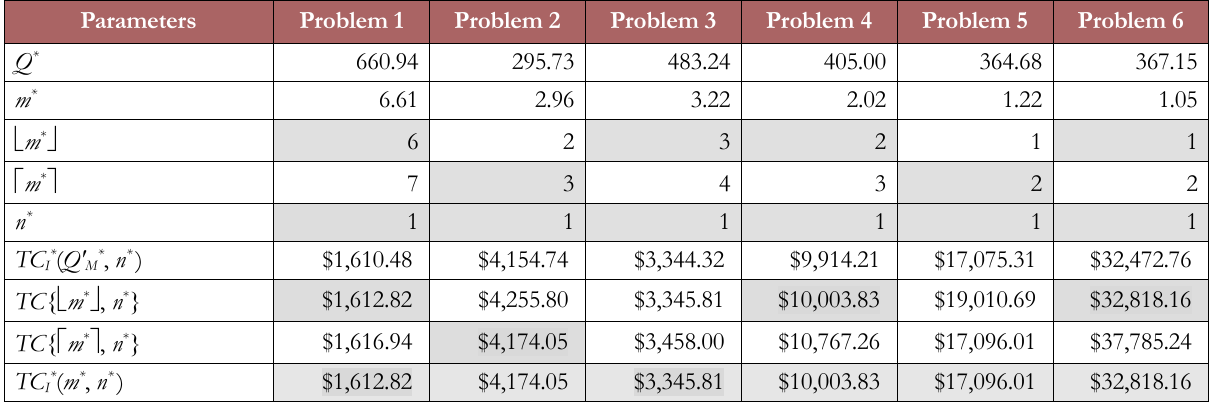
Table 2. Results obtained by using modified Hook and Jeeves